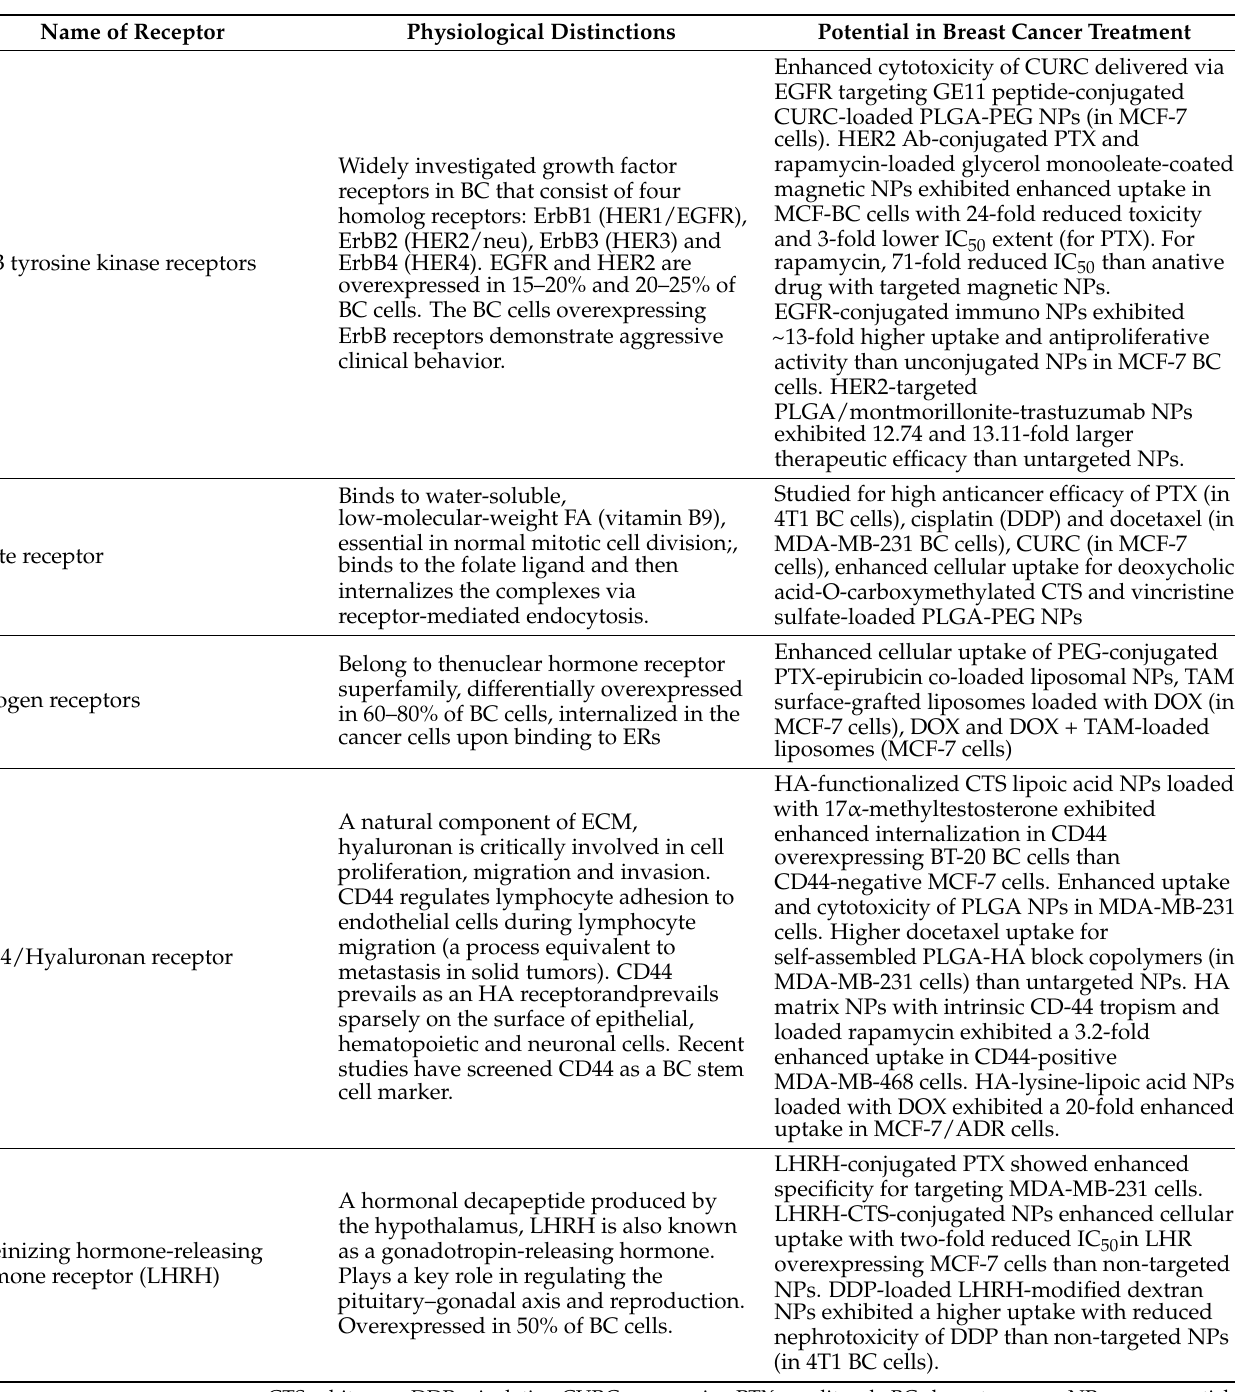
Table 1. Prominent surface receptor proteins overexpressed on breast cancer cells